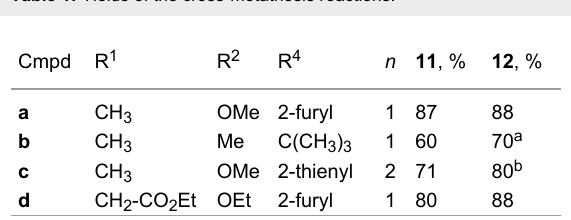
Table 1: Yields of the cross-metathesis